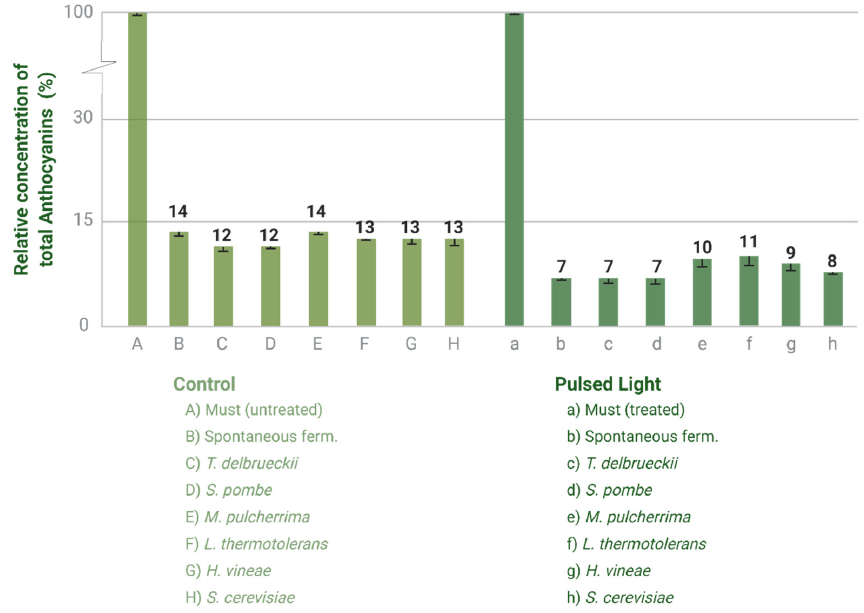
Figure 4. Percentage loss of anthocyanins in ( left ) wines produced with untreated grapes and ( right ) wines produced with treated grapes.